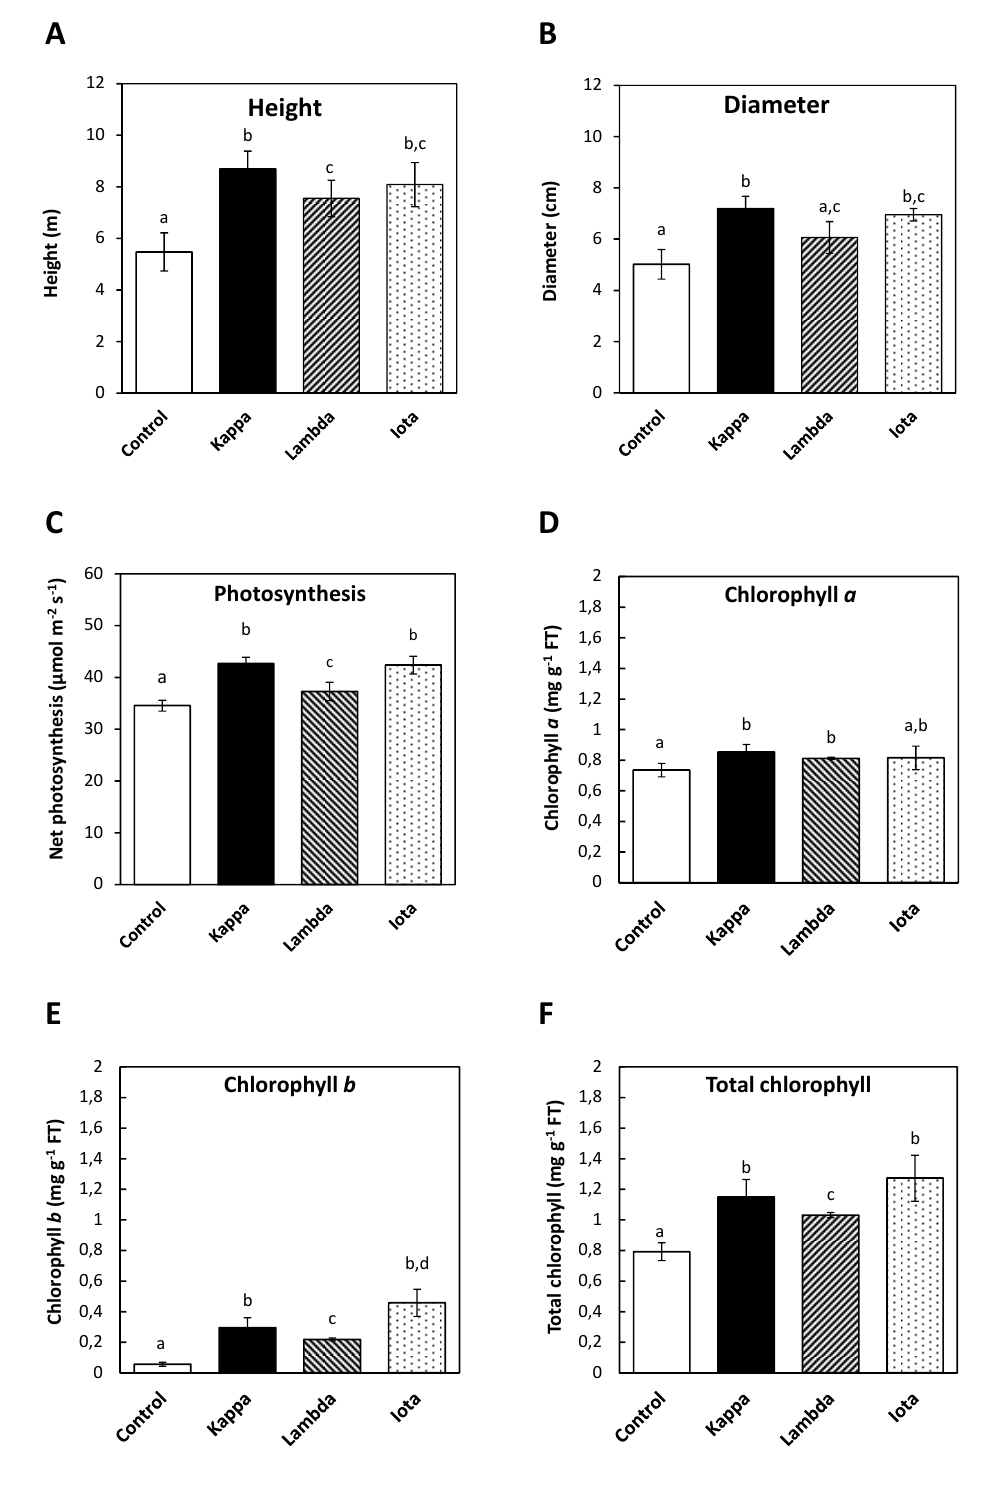
Figure 1. Height ( A ) and trunk diameter ( B ), net photosynthesis ( C ), and contents of chlorophyll a ( D ) and b ( E ) and total chlorophyll ( F ) in control Eucalyptus (control) and in trees treated with oligo-carrageenans (OCs) kappa, lambda and